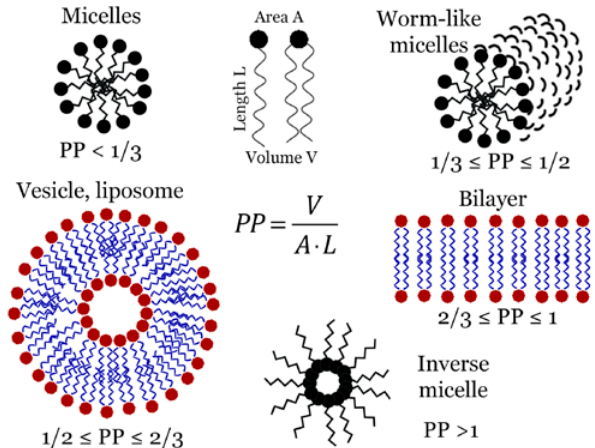
Figure 4. Spontaneous self-assembly in water of fatty acids charac- terized by the volume V of the hydrocarbon tail, the area A of the head-group, the maximum chain length L and observed topologies as a function of the packing parameter